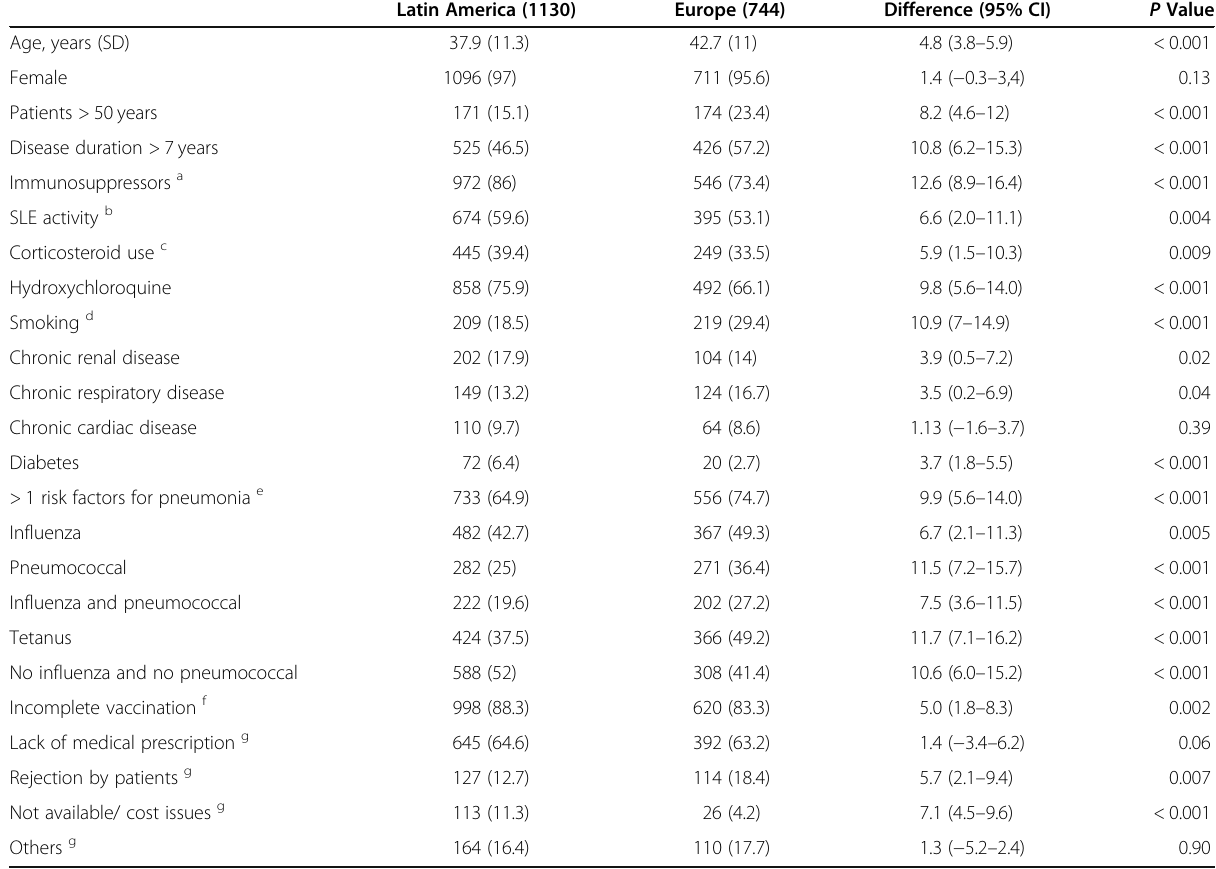
Table 5 Comparison between Latin American and European patients